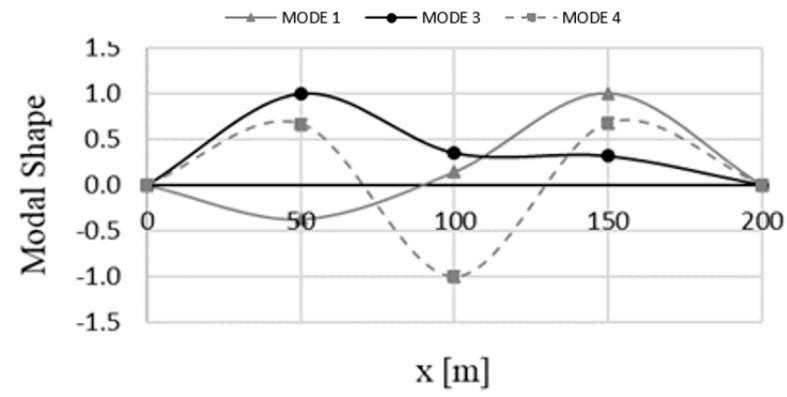
Figure 6. Bridge modal shape: most relevant modes in the transversal